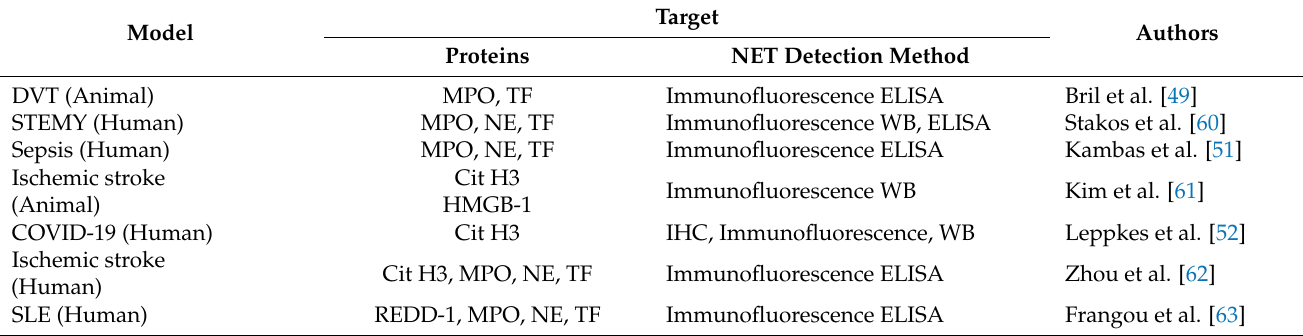
Table 2. Studies of NETs in thromboinflammation. Myeloperoxidase, MPO; Neutrophil Elastase, NE; High Mobility Group Box 1, HMGB-1; Deoxyribonucleic Acid, DNA; ST-segment elevation myocardial infarction, STEMI; Interleukin-1b, IL-1b; Interleukin-17, IL-17; Western blot, WB; Immunohistochemistry staining, IHC; systemic lupus erythematosus, SLE; Regulated in development and DNA damage responses 1, REDD-1; and Deep Vein Thrombosis,